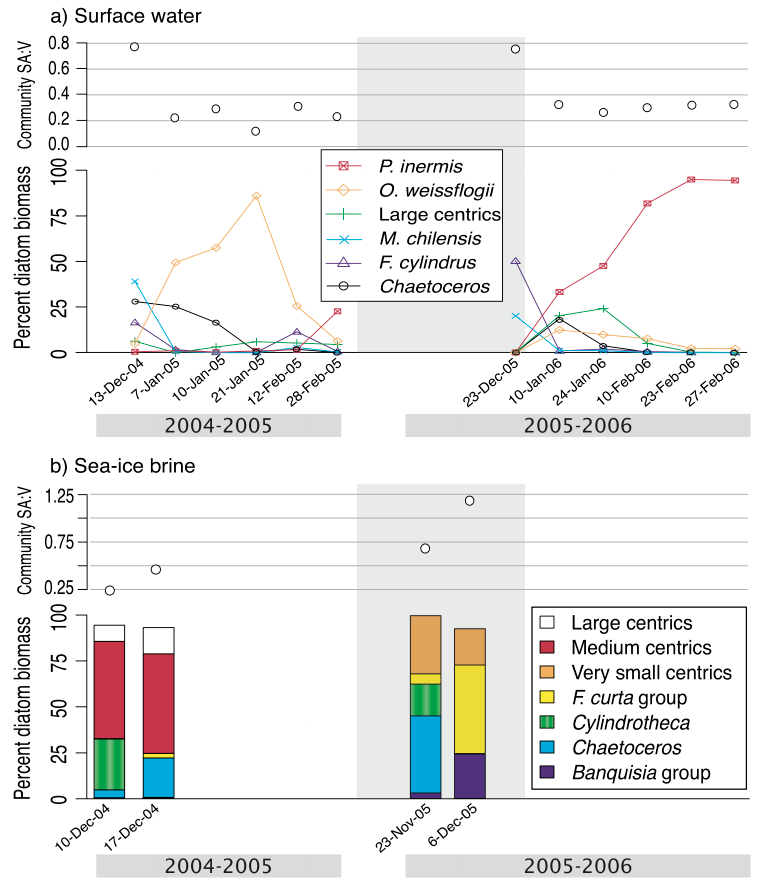
Fig. 5. Time-series analysis of diatom assemblages for (a) surface waters and (b) sea ice brine, presented as percentage of total diatom biomass. Upper panel dots show community SA:V. Species/groups shown are the Banquisia group (as defined in Annett et al., 2010), Chaetoceros ( Hyalochaeta subgenus), Fragilariopsis curta group (see text), Fragilariopsis cylindrus , Minidiscus chilensis , Odontella weiss- flogii and P. inermis . Size fractions of centric diatoms are < 10µm, 20 to 50µm and > 50µm, for very small, medium and large cells, respectively. The very small fraction is likely comprised of Thalassiosira auxospores, while other centric size classes are predominantly Thalassiosira species but also include species from the genera Actinocyclus Porosira and Stellarima